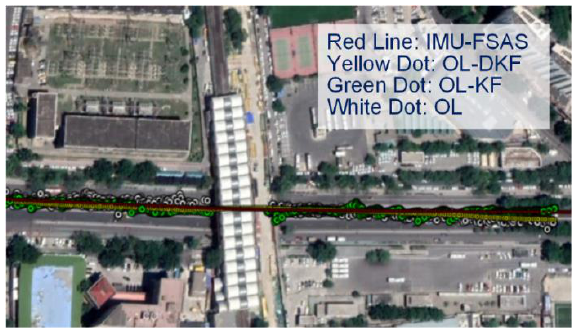
Figure 21. Satellite visibility of roads blocked by a light railway test.